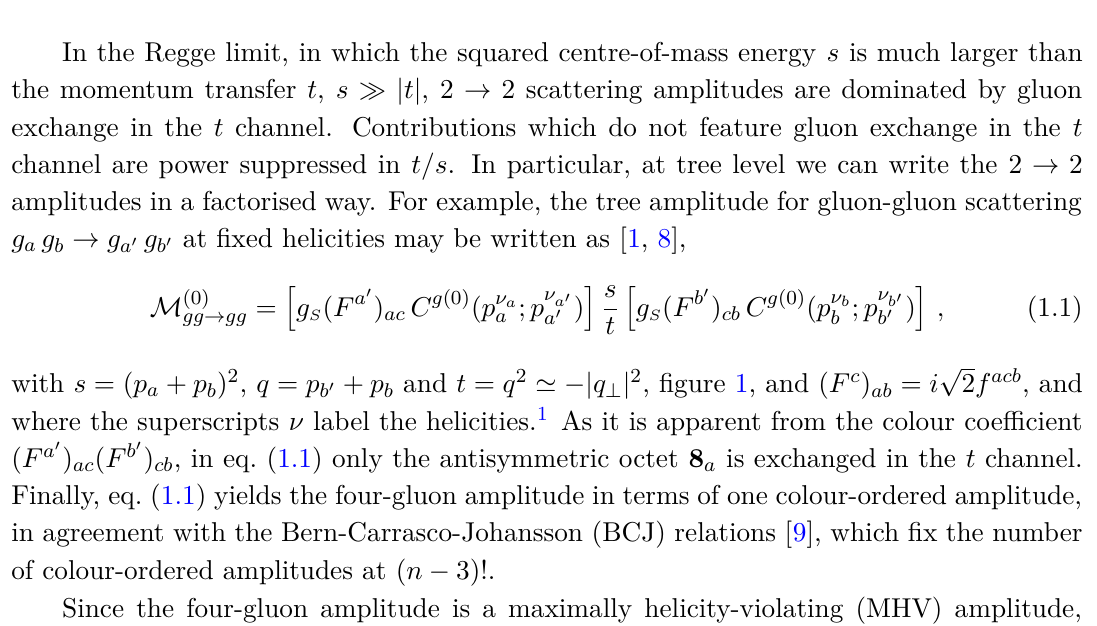
Figure 1 . Amplitude for gg → gg scattering in the Regge limit. The green blobs represent the impact